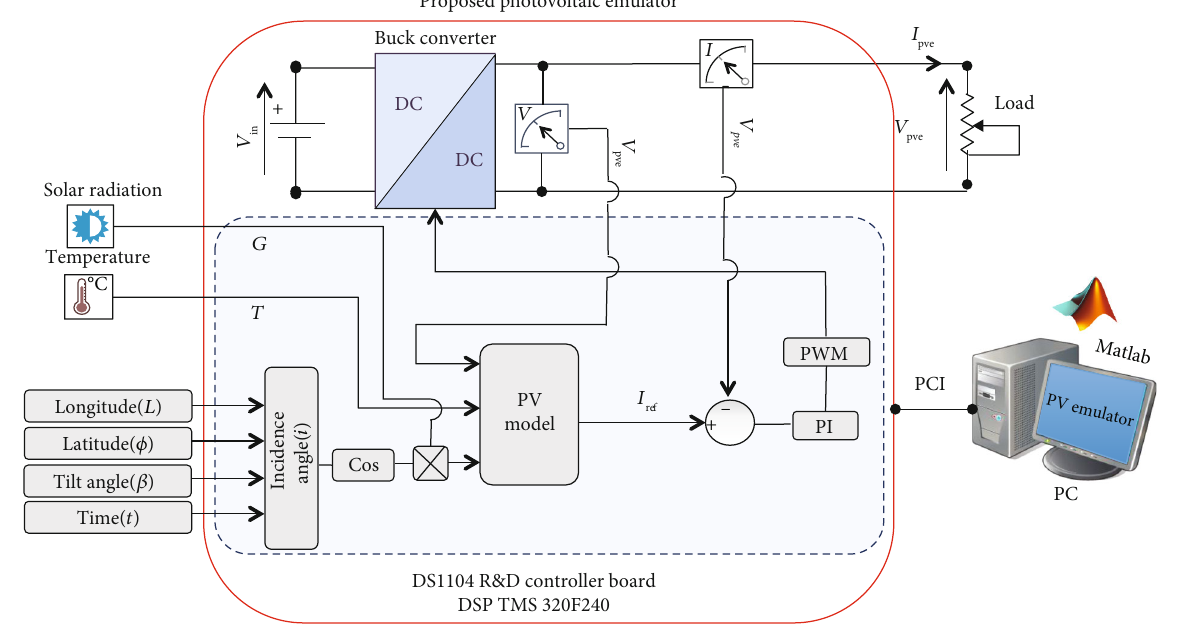
Figure 3: Proposed photovoltaic emulator architecture.